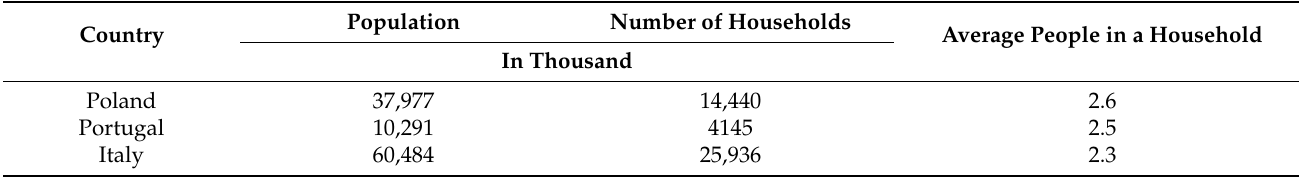
Table 1. Households in the surveyed countries.